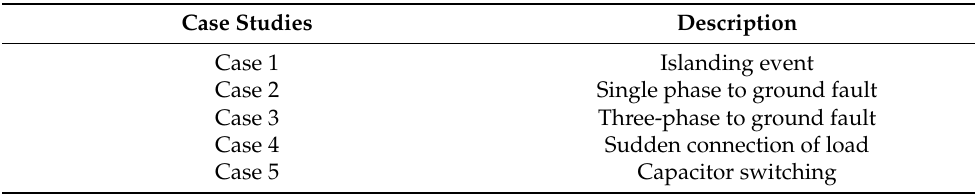
Table 1. Different proposed